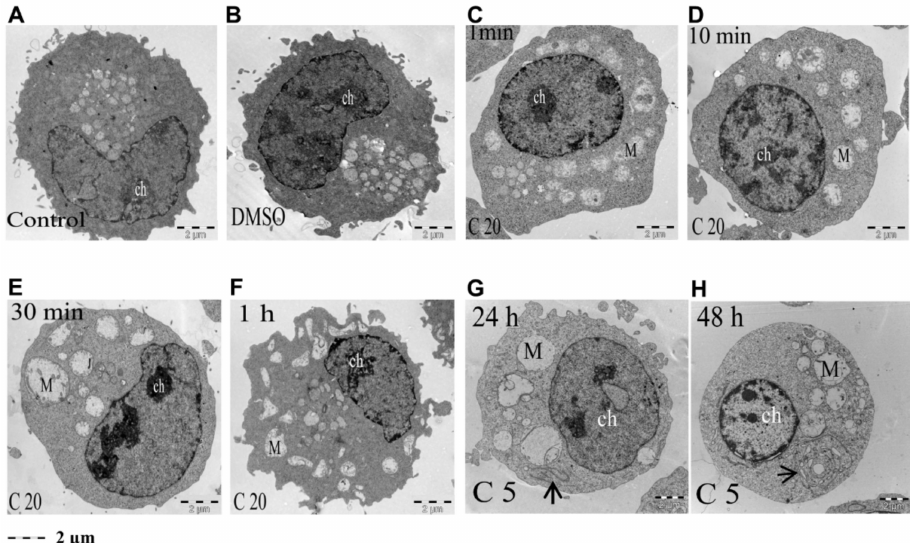
Figure 3. COL-3-induced morphological changes assessed with TEM (low magnification). K562 control cells were left untreated ( A ) or were treated with vehicle DMSO ( B ) or with 20 µ g/mL COL-3 for 1 min, 10 min, 30 min and 1 h ( C – F , respectively) and 5 µ g/mL COL-3 for 24 h and 48 h ( G , H , respectively). Thereafter, ultrastructural morphology was assessed by TEM. M = mitochondria; ch = chromatin; arrows indicate